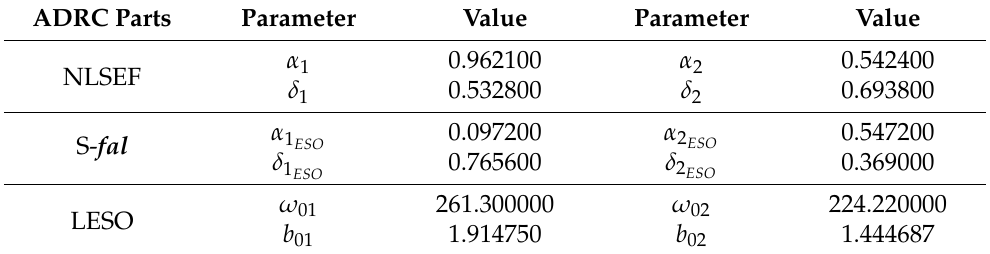
Table 11. S f al -ADRC parameters.